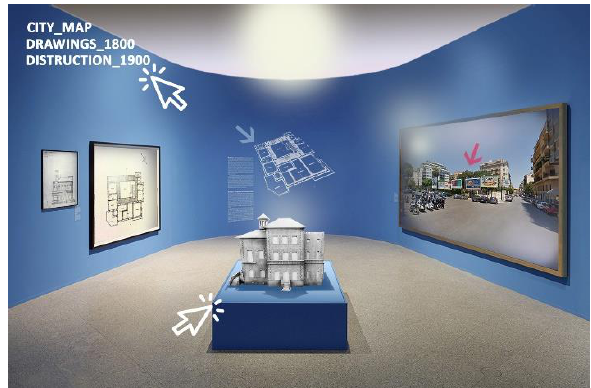
Figure 7. The image shows the way to use a hypothetic app with which the user can immerse himself in the virtual exhibition and have all the desirable information (graphic design by A.R.D. Accardi, 2019)